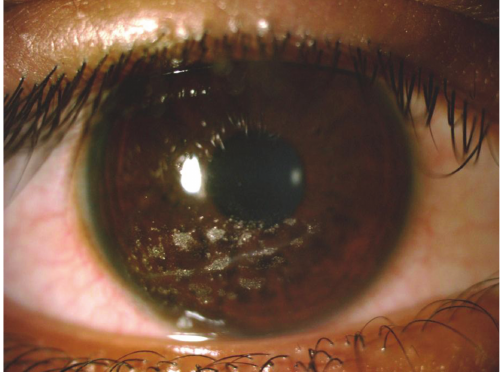
Figure 1: Graphite particles seen within the corneal stroma of the right